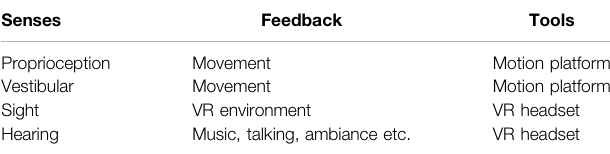
TABLE 1 | Human senses considered for VR rehabilitation. Senses Feedback Tools Proprioception Movement Motion platform Vestibular Movement Motion platform Sight VR environment VR headset Hearing Music, talking, ambiance etc. VR